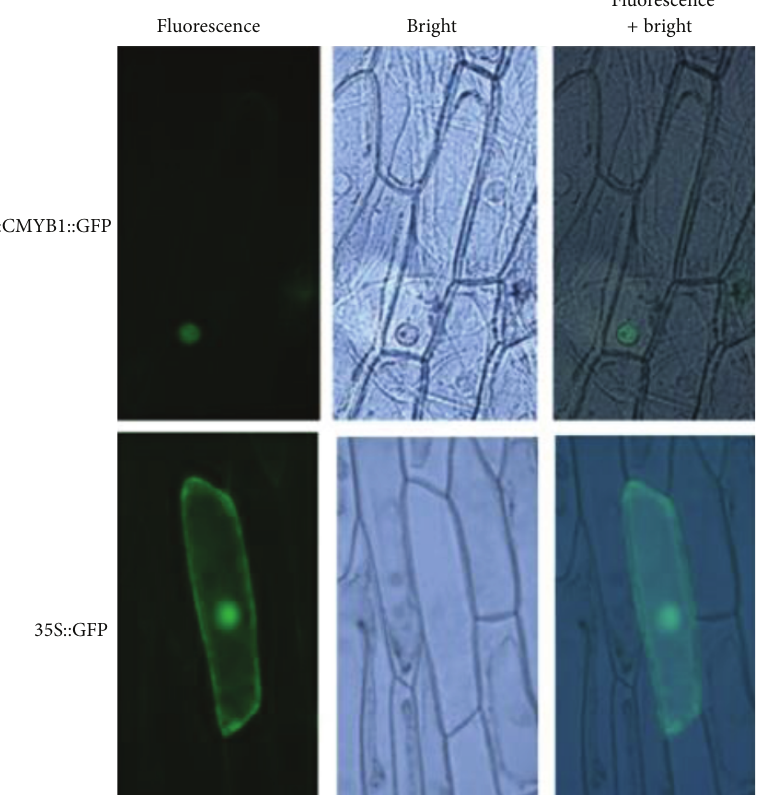
Figure 5: Subcellular localization of CMYB1 . The 35S:: CMYB1 ::GFP which was constructed in pA7 vector and the empty vector harboring 35S::GFP were transformed into onion epidermis cells,